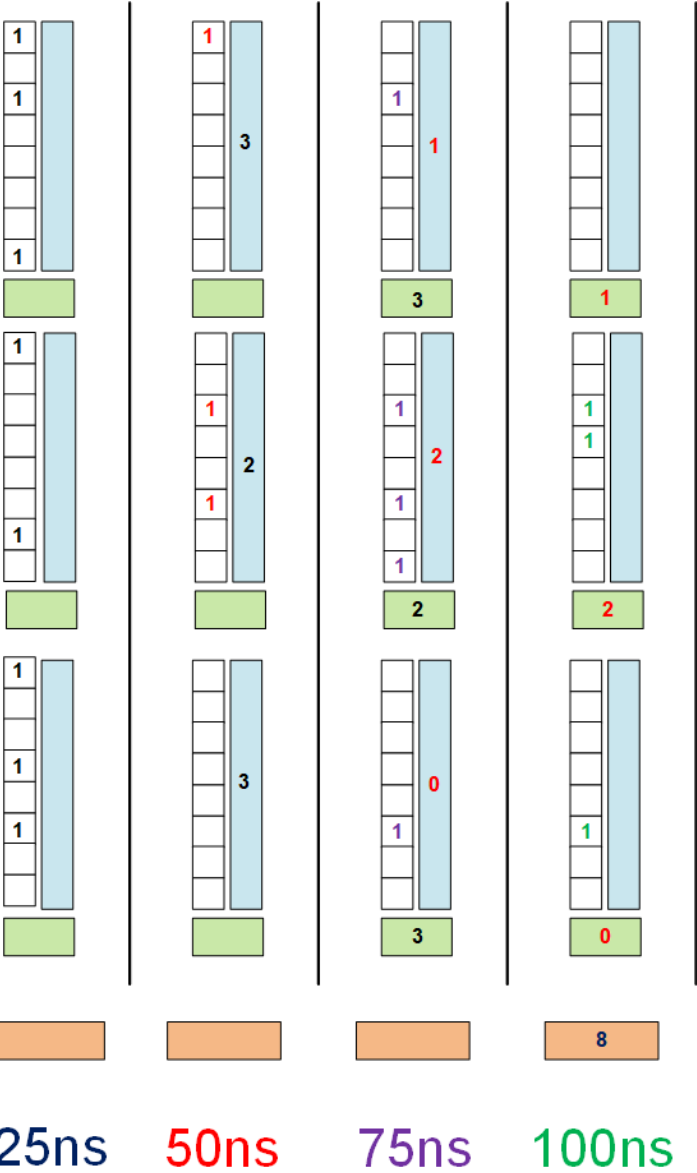
Figure 12. Diagram illustrating how the addition scheme could be expanded to cover a larger area. White boxes represent blocks of 320 pixels, blue boxes are the previously discussed summation scheme, and green boxes represent the additional pipeline suggested for future devices. Orange boxes indicate the peripheral logic. The different coloured numbers represent hits occurring at each of the similarly coloured time steps, and being summed as the pipeline